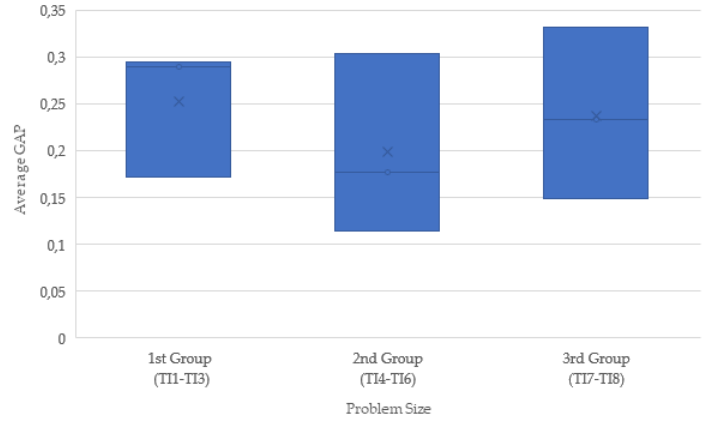
Figure 6. Box chart for the Tabu List-Based Algorthm (TLBA) average